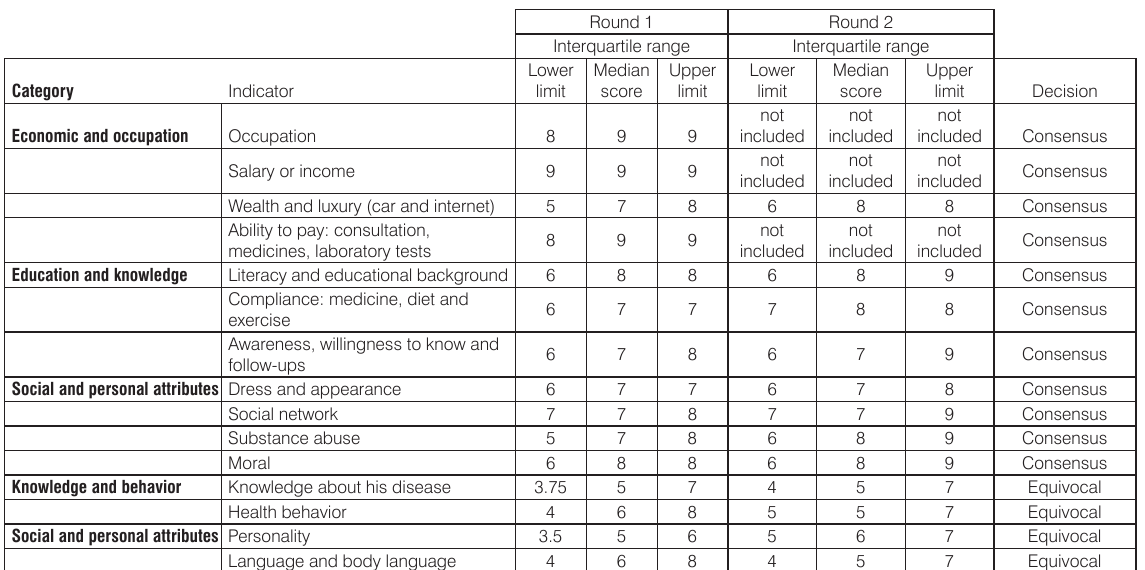
Table 2. Physician defined socioeconomic indicators.